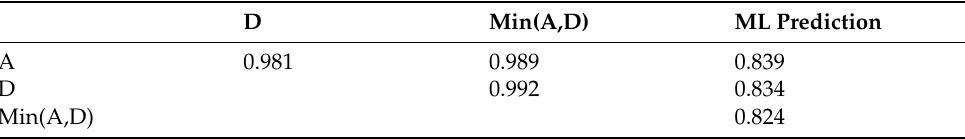
Table 2. The intra-class correlation coefficient between physicians and ML of the BBS scores. All p -values <